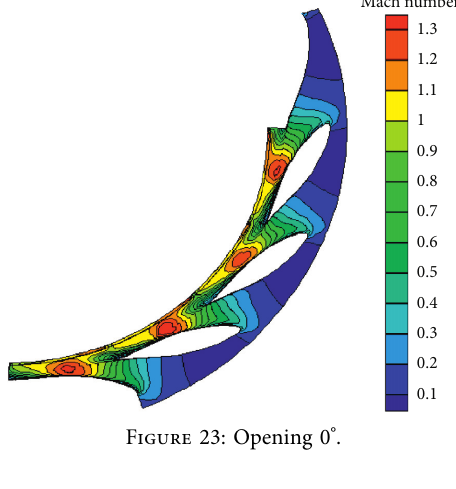
Figure 23: Opening 0 ° .